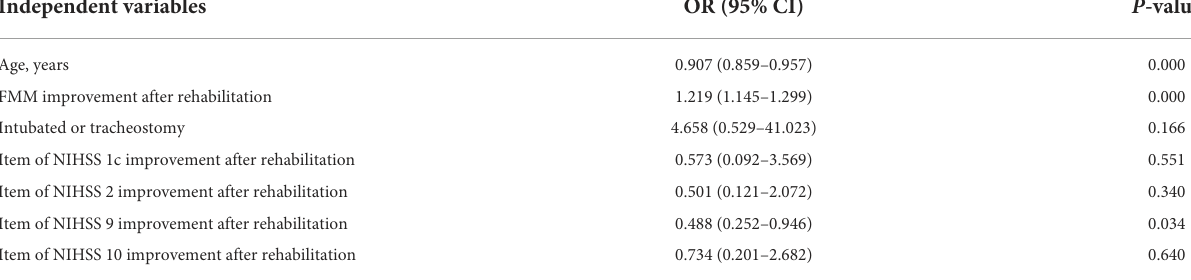
TABLE 5 Prediction Model 2—Multivariate analysis for NGT removal after rehabilitation in PSD patients with NIHSS subscores. Independent